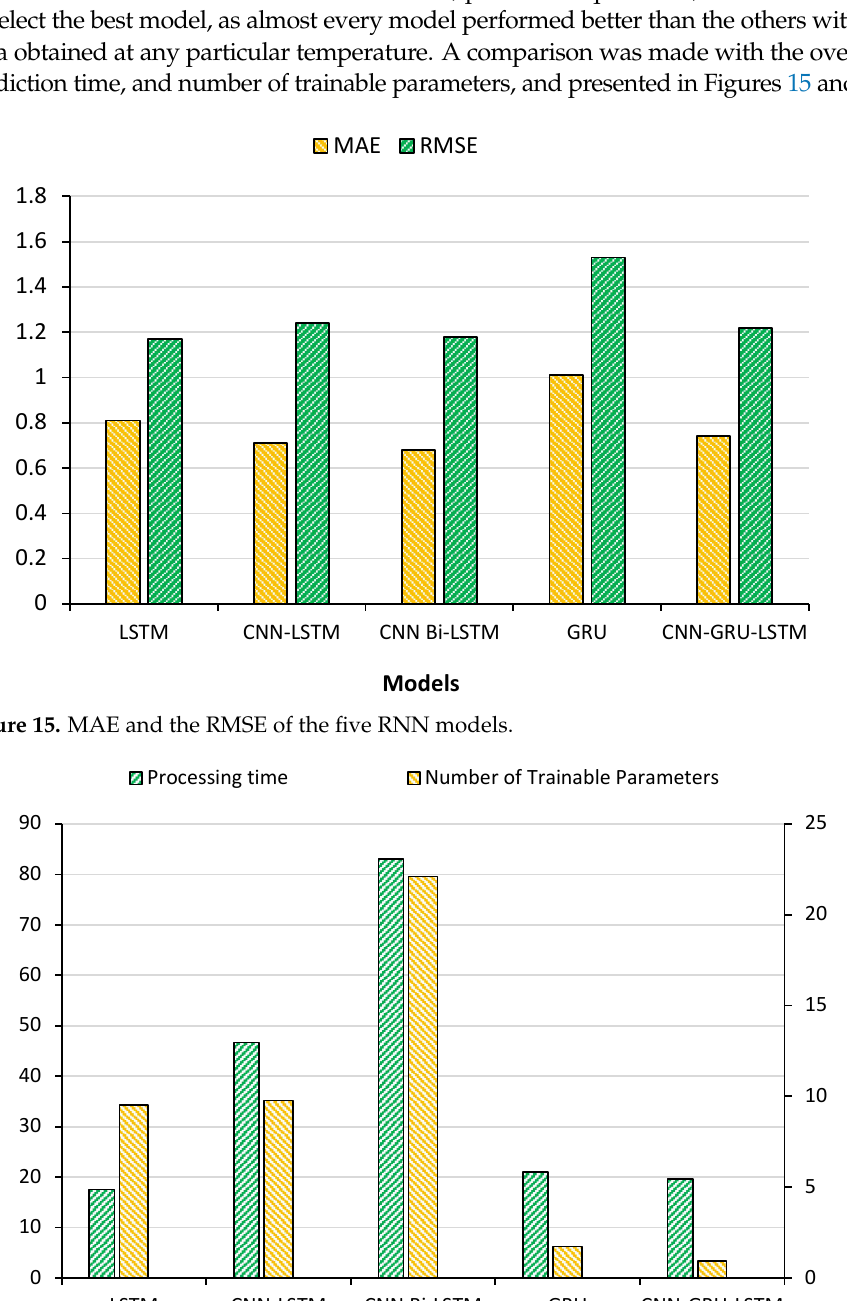
Figure 16. Comparison of the models with respect to the processing time and trainable parame- ters.